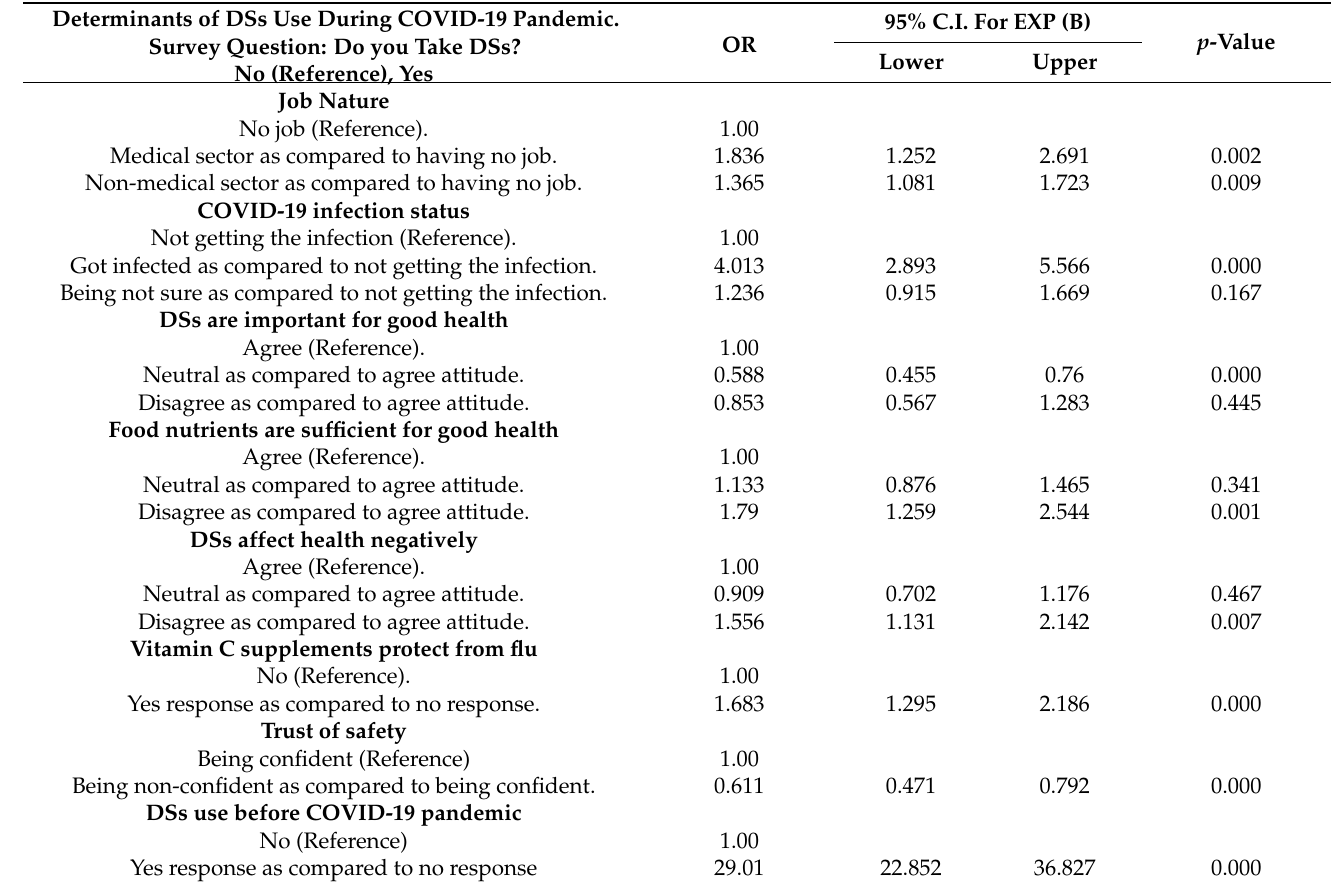
Table 4. Regression Analysis, Backward LR Odds Ratio (Model